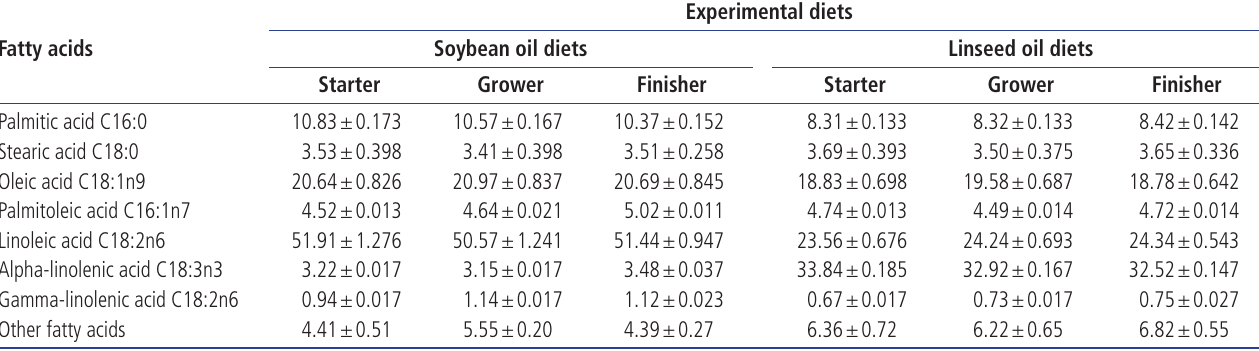
Table 3. Fatty acid composition (% of total fatty acids) of the diets used in the experiments Fatty